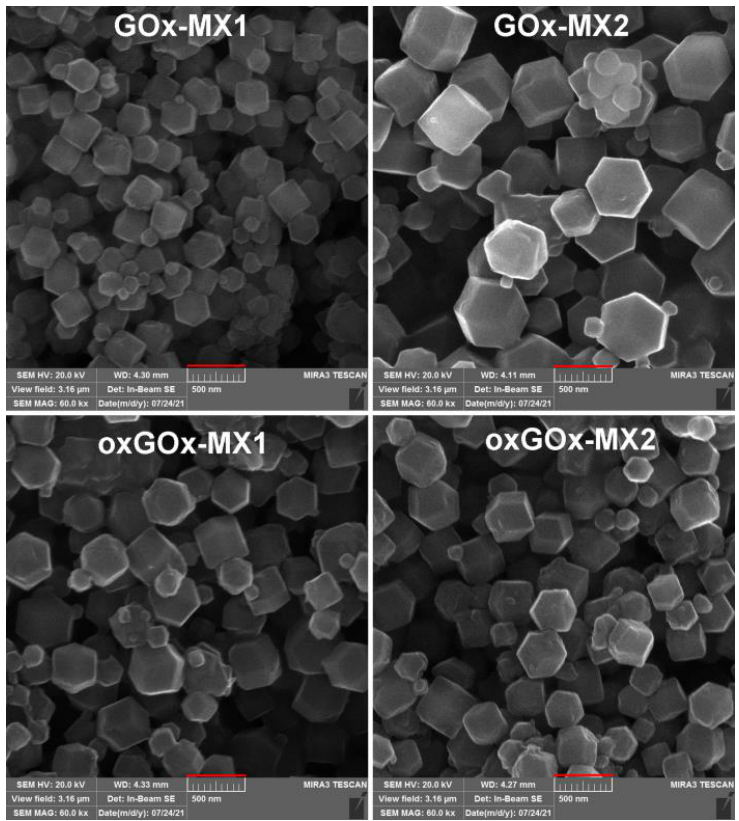
Figure 3. SEM images of biocomposites after washing with water (scale bar 500 nm).